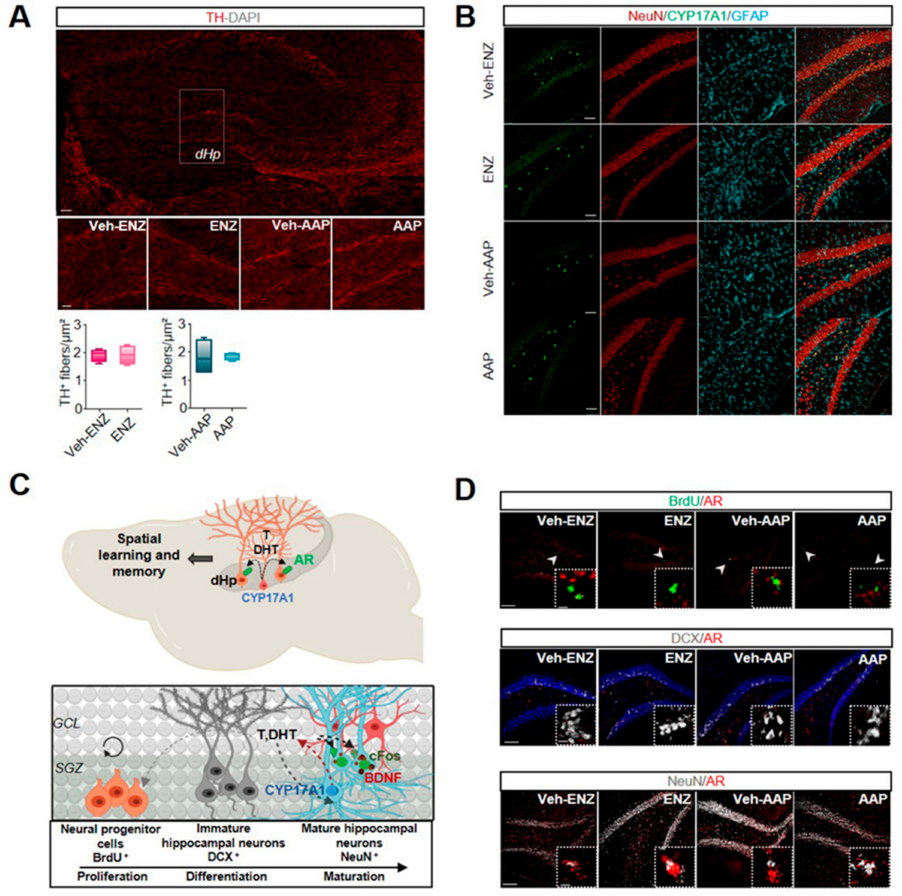
Figure 7. AAP and ENZ treatment impairs adult neurogenesis and neuronal activity in dorsal hippocampus respectively. Note. ( A ) Immunofluorescence of TH+-DA projections to dHP of ENZ-, AAP- and vehicle-treated mice (seen on magnification of squared areas). Whisker boxes represent the number of TH+ fibers in dHP. Statistical quantifications were performed using Mann–Whitney test. Bars are mean ± SEM ( n = 4 mice). Scale bars: 100 µ m. ( B ) Representative immunofluorescence of CYP17A1 (green), NeuN (red) and GFAP (cyan) in the DG of dHP of ENZ-, AAP- and vehicles-treated mice showing specific localization of CYP17A1 in neuronal and not glial cells. ( C ) Upper panel, schematic of mouse dorsal hippocampal (dHp) CYP17A1-mediating production of testosterone and DHT, potentially responsible for spatial learning deficits. Lower panel, hypothetical illustration of the impact of testosterone and DHT or prednisolone on neurogenesis. CYP17A1 expression by mature hippocampal neurons (neuron in light blue; astrocyte in red) of granule cell layer (GCL) of DG; AR is not expressed in neural progenitors cells stained by an anti-BrdU (orange) in the SGZ and by immature hippocampal neurons classically revealed by staining of an anti-DCX (grey) in the DG of vHP. AR expressed by mature hippocampal neurons revealed by anti-NeuN (light blue). AR (green) activation by T or DHT would control mature neuron (blue) activity as illustrated by c-fos immunolabeling. ( D ) Upper panel, representative immunolabeling of BrdU (green) and AR (red) immunofluorescence in dHP of ENZ-, AAP- and vehicles-treated mice. The boxed areas showed a magnification of lack of BrdU+/AR+ co-stained progenitor cells. Middle panel, immunolabeling of DCX (grey) and AR (red) immunofluorescence in dHp of ENZ-, AAP- and vehicle-treated mice. The boxed areas showed a magnification of lack of DCX+/AR+ co-stained immature migratory neurons in the SGZ. Lower panel, immunolabeling of NeuN (grey) and AR (red) in dHp of ENZ-, AAP- and vehicle-treated mice. The boxed areas showed a magnification of NeuN/AR co-expression in mature neurons. Scale bar: 100 µ m and 50 µ m. AAP, abiraterone acetate-prednisone; AR, androgen receptor; BrdU, Bromodeoxyuridine; c-fos, cellular oncogene c-fos; CYP17A1, Cytochrome P450 Family 17 Subfamily